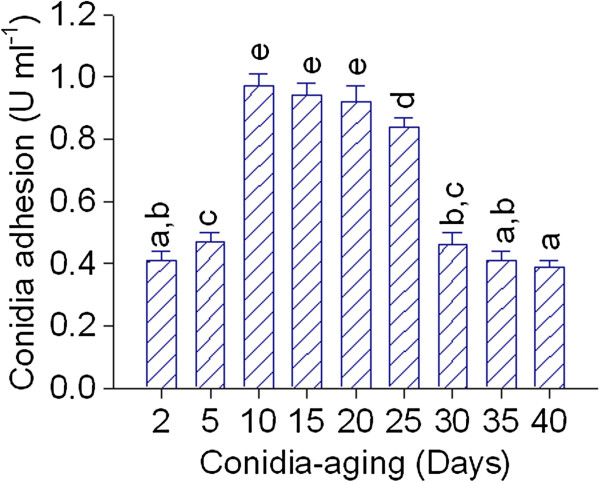
Effect of A. niger MYA 135 conidia-aging on adhesion to polystyrene well. Error bars represent the standard deviation calculated from at least three independent experiments. Bars with the same letter are not significantly different.